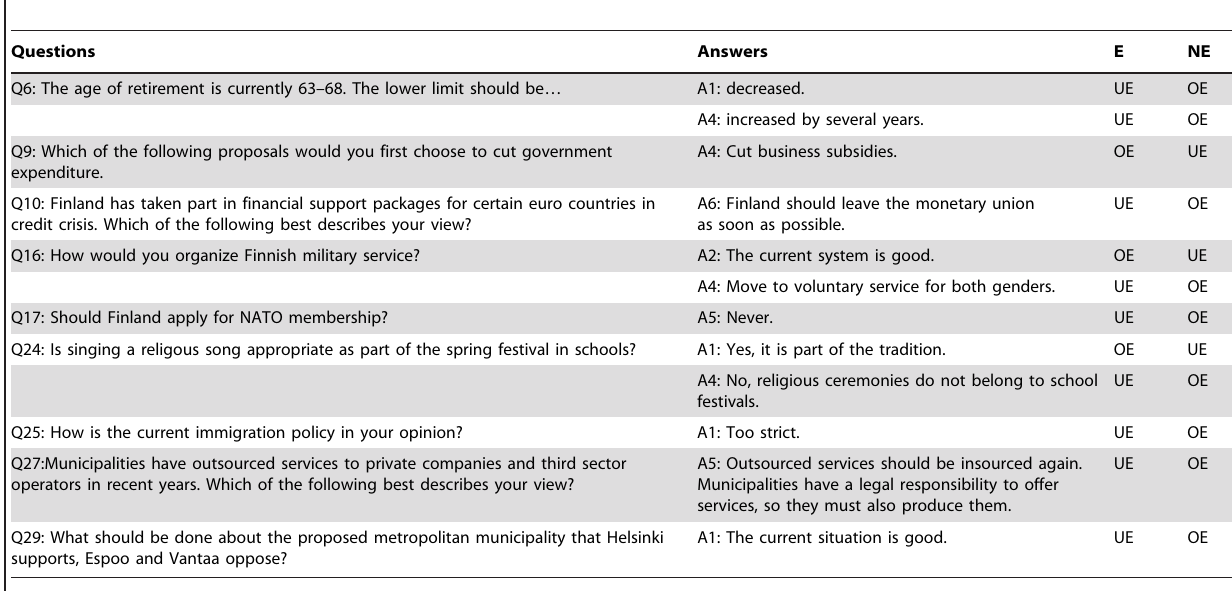
Table 3. Over-expressed (OE) and under-expressed (UE) endorsement of a specific answer (second column) given to the related question (first column) by non elected (NE) or by elected (E) candidates